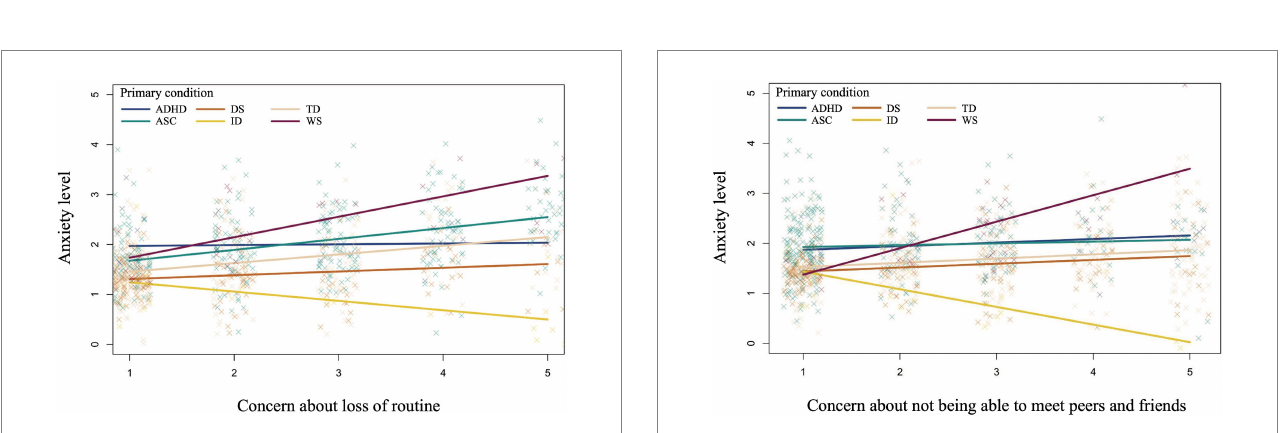
FIGURE 6 Three-way interaction for individual’s primary condition, concern about not being able to meet peers and friends, and anxiety. Anxiety and concerns are measured with a 5-point Likert scale from 1 (not anxious/ not concerned at all) to 5 (very anxious/extremely concerned). The level of anxiety and concern of individuals with NDCs and TD siblings was reported by their parents or caregivers. NDCs = neurodevelopmental conditions, ADHD = attention deficit disorder (with or without hyperactivity), ASC = autism spectrum condition, DS = Down syndrome, ID = intellectual disability, WS = Williams syndrome, TD = typically developing.